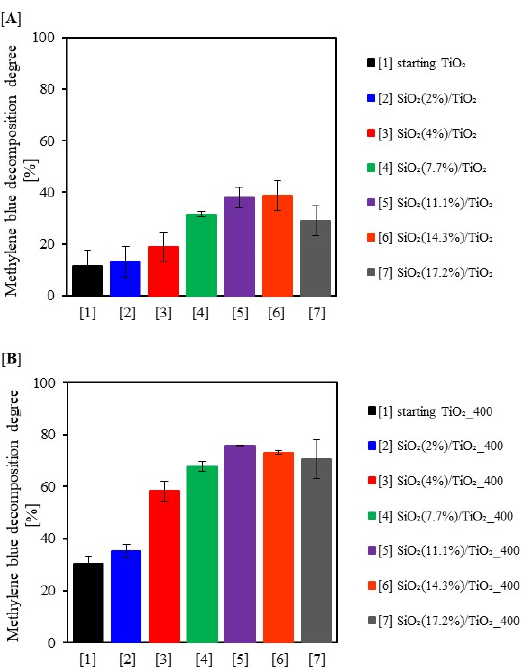
Figure 9. Methylene blue decomposition degree after 5 h of UV light irradiation for starting TiO 2 and silica-modified TiO 2 prior ( A ) and after calcination at 400 °C ( B ). In order to better understand the photocatalytic degradation of methylene blue, the apparent reaction rate constants were determined. The degradation of methylene blue for the starting TiO 2 _400 followed the zero-order model. However, for SiO 2 (4%)/TiO 2 , SiO 2 (7.7%)/TiO 2 , SiO 2 (17.2%)/TiO 2 , SiO 2 (4%)/TiO 2 _400, SiO 2 (7.7%)/TiO 2 _400 and SiO 2 (11.1%)/TiO 2 _400, the dye degradation followed a pseudo-first-order model. For all other samples, the degradation followed a pseudo-second-order model. The linear trans-